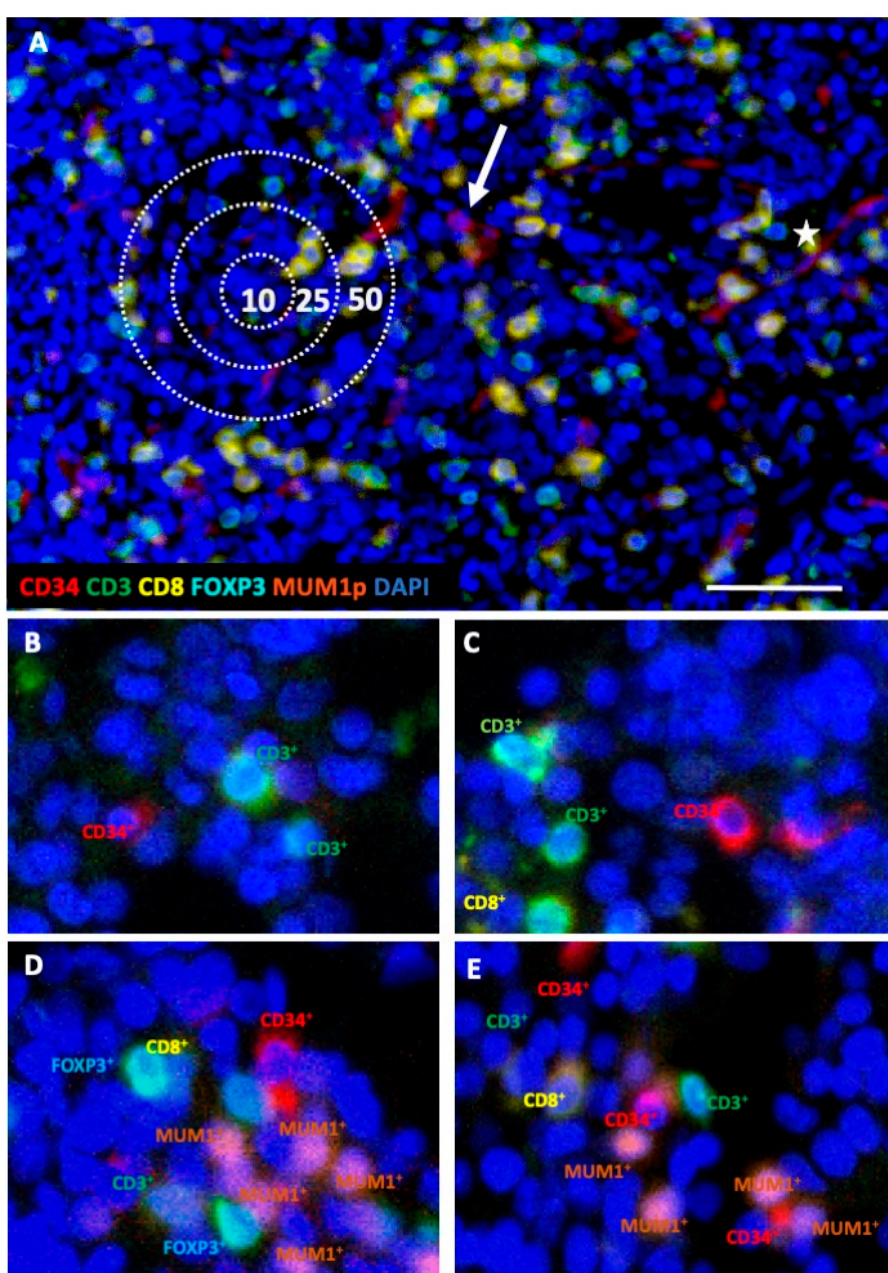
Figure 1. Representative multiplex immunohistochemistry (IHC) of BMB from controls and MDS patients. All BMB were stained with a five-color antibody panel consisting of CD34 (red), CD3 (green), CD8 (yellow), FOXP3 (turquoise), MUM1p (orange) antibodies, and counterstained with DAPI (blue). ( A ) Representative BMB with MDS with multi-lineage dysplasia without excess of blasts (MDS-MLD). The intercellular distance algorithm with four categories was defined as follows: (i) direct intercellular contact, (ii) cells within a radius of 10 μ m, (iii) of 25 μ m, and (iv) of 50 μ m; the scale bar is 50 μ m. One representative CD34 + blast with circular membranous staining pattern is highlighted with an arrow. In comparison, CD34 + endothelial cells with luminal line-shaped positivity are marked with a star. ( B , C ) two representative control BMB with a homogeneous staining pattern comprising only few CD3 + CD8 − T cells, but no CD3 + CD8 + and no CD3 + FOXP3 + T cells in a radius of <10 μ m to CD34 + HSPC. ( D , E ) two representative MDS samples are presented, which displays variable, but generally higher frequency of different T and B/plasma cell subpopulations in close proximity of the CD34 + blasts.